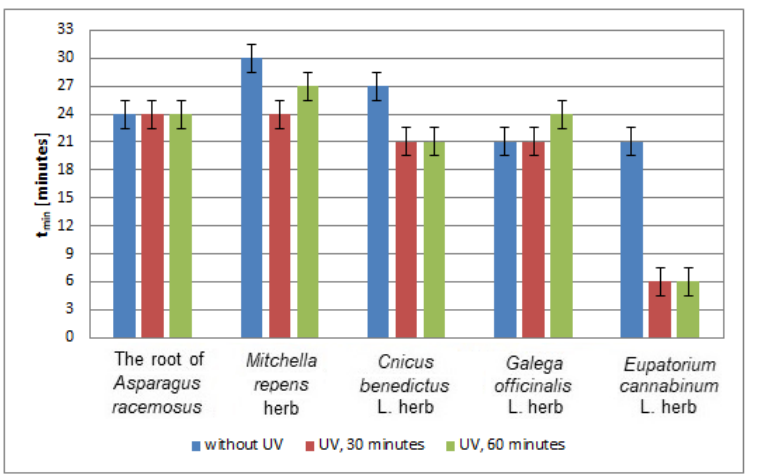
Figure 12. Comparison of the times ( t min ) to reach the minimum value by the relative amplitudes (A/A DPPH ) of the EPR spectra of DPPH free radicals interacting with infusions of the root of Asparagus racemosus , Mitchella repens herb, Cnicus benedictus L. herb, Galega officinalis L. herb, and Eupatorium cannabinum L. herb. A—amplitude of the EPR line of DPPH free radicals in contact with the tested samples. A DPPH —amplitude of the EPR line of DPPH free radicals in the reference solution. Data for the infusions obtained from the plant materials exposed to UVA radiation for 30 and 60 min. Data for the infusions of the plant material that was not exposed to UVA radiation are also given.